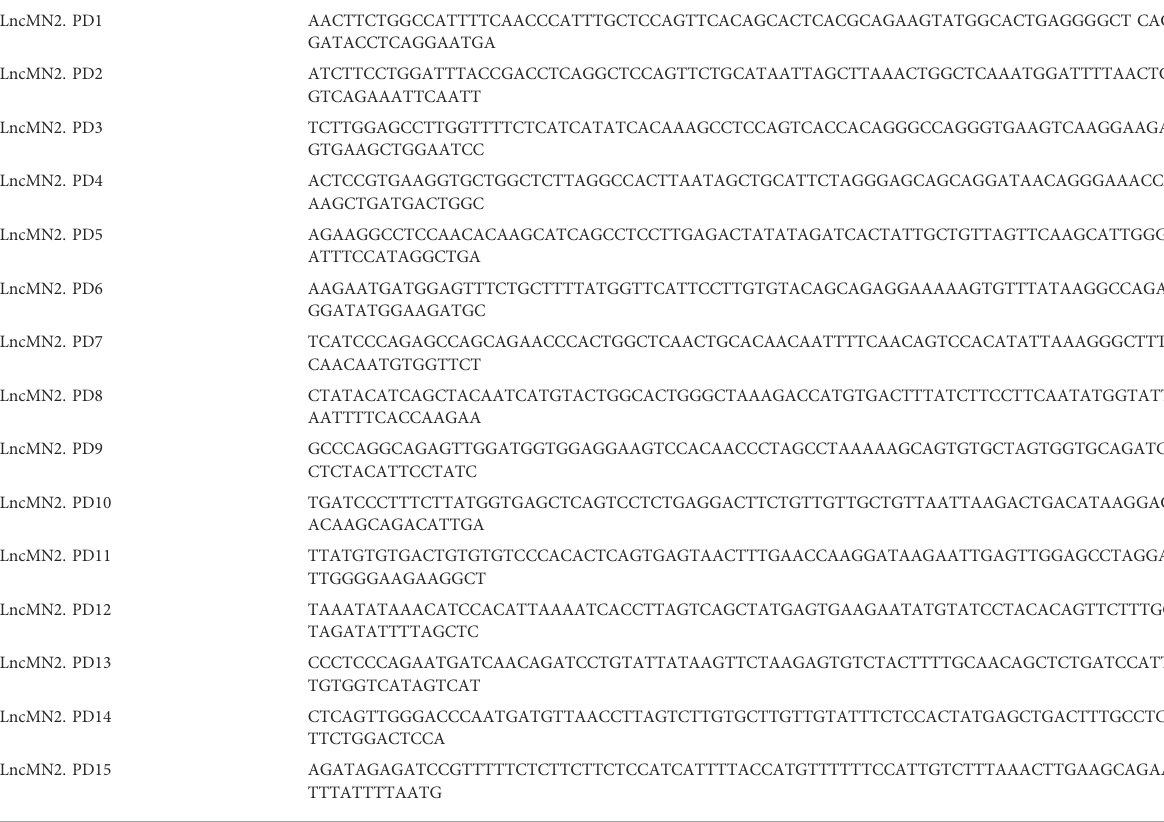
TABLE 1 List of biotinylated probes used for LncMN2 RNA Pull